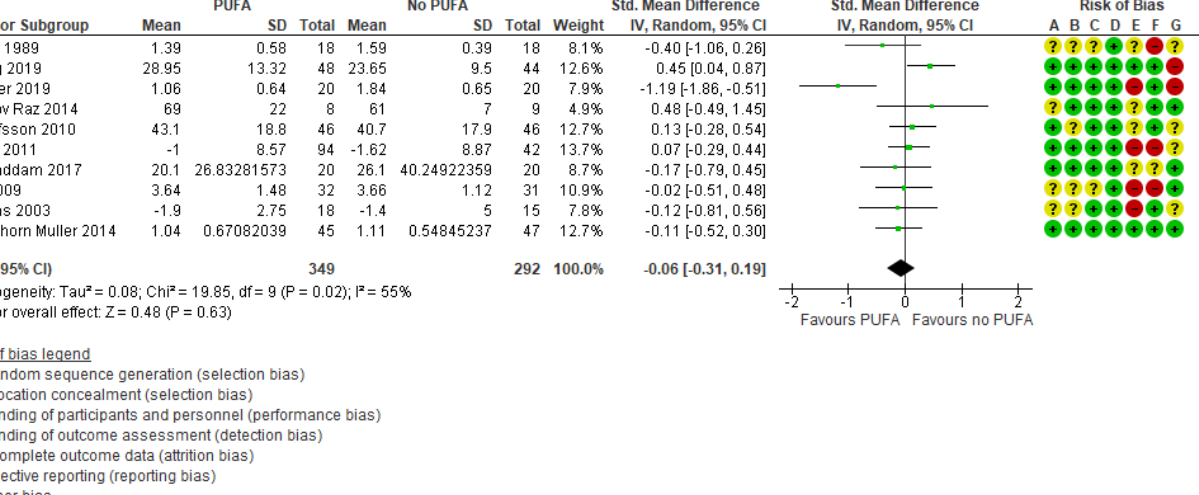
Figure 3. Forest plot of comparison: PUFA vs. placebo, outcome: parent-reported core symptoms (end of treatment). Green square indicates summary estimates of the individual studies. Black diamond indicates total summary effect estimate.